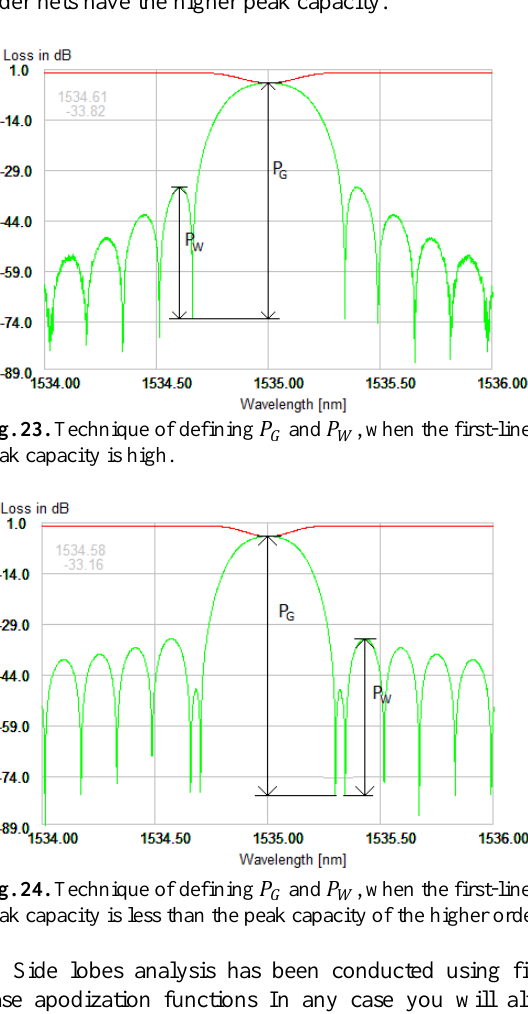
Fig. 24. Technique of defining and , when the first-line peak capacity is less than the peak capacity of the higher order. 𝑃𝑃 𝐺𝐺 𝑃𝑃 𝑊𝑊